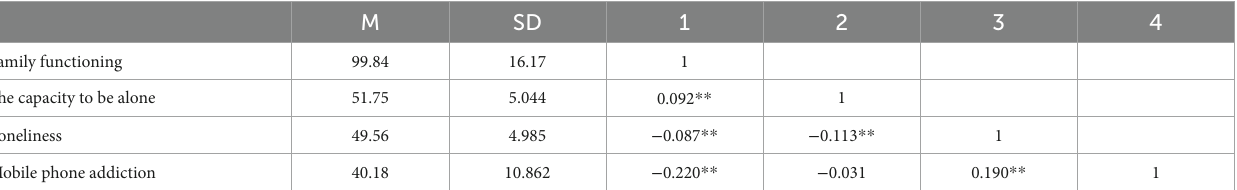
TABLE 2 Descriptive statistics of means, SD, and Pearson’s